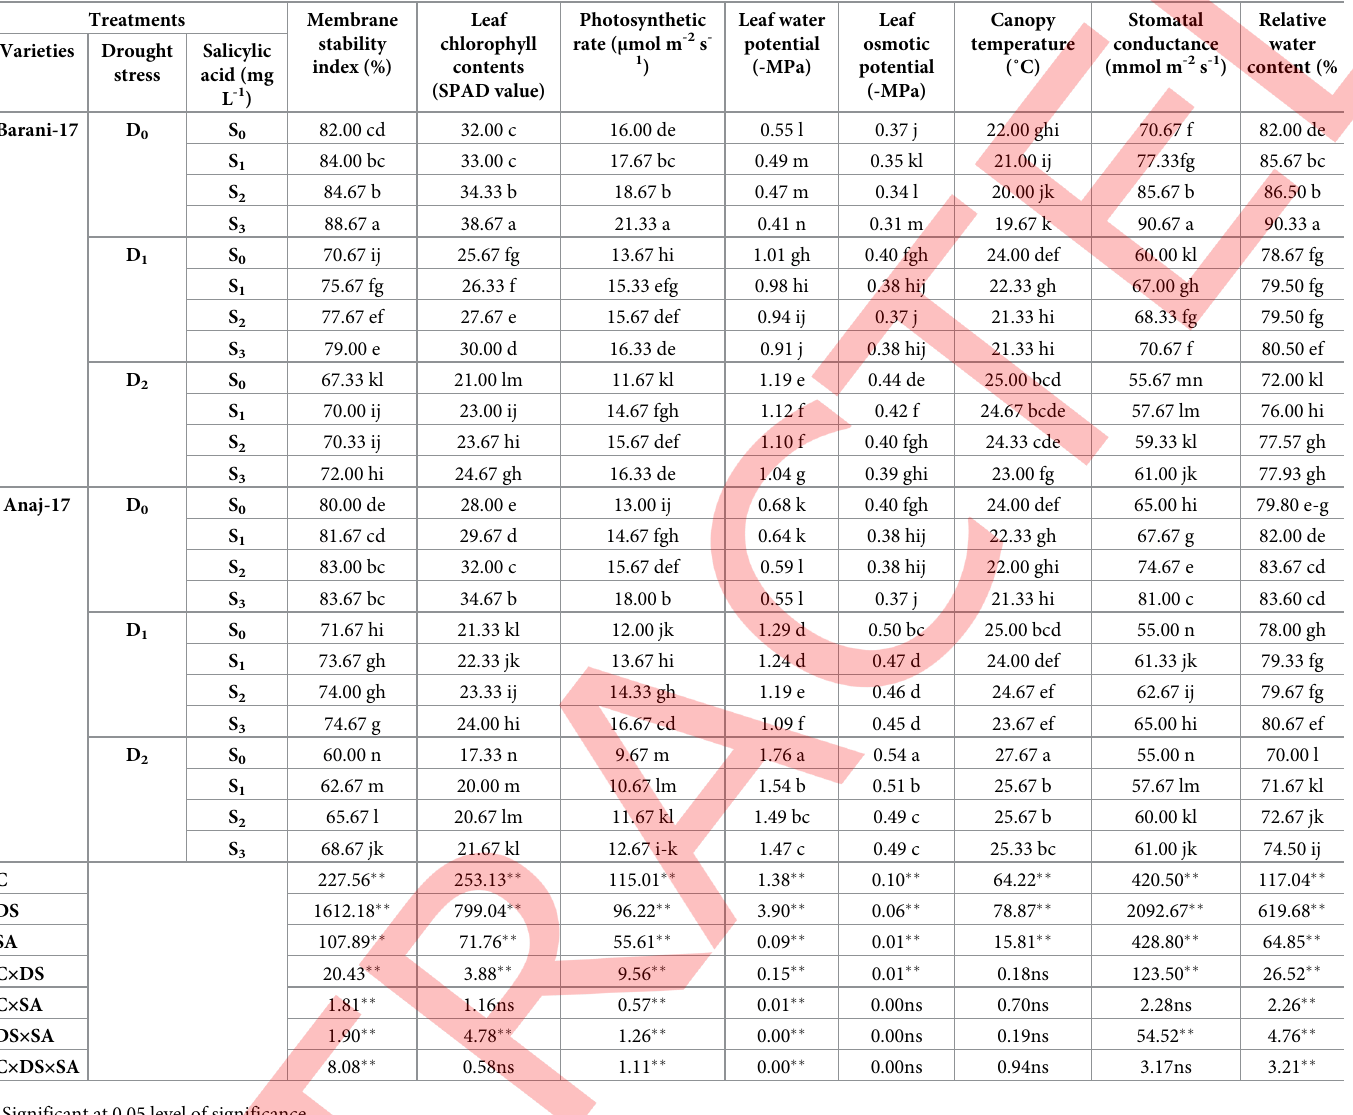
Table 4. Influence of foliar application of salicylic acid on physiological attributes of wheat cultivars grown under drought stress conditions. Treatments Membrane